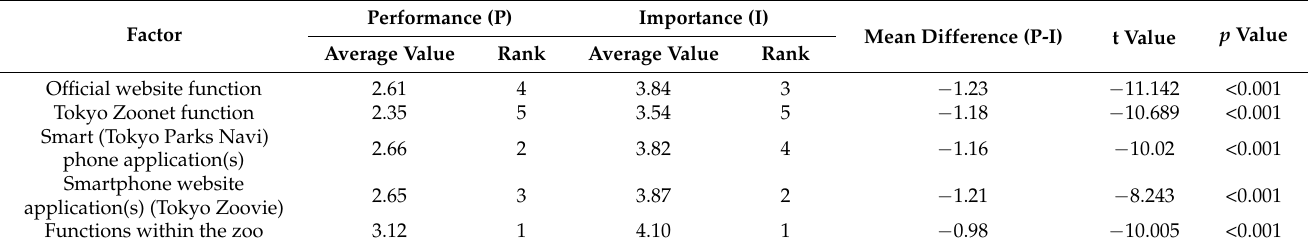
Table 15. Means and ranking of items at the first level of classification.